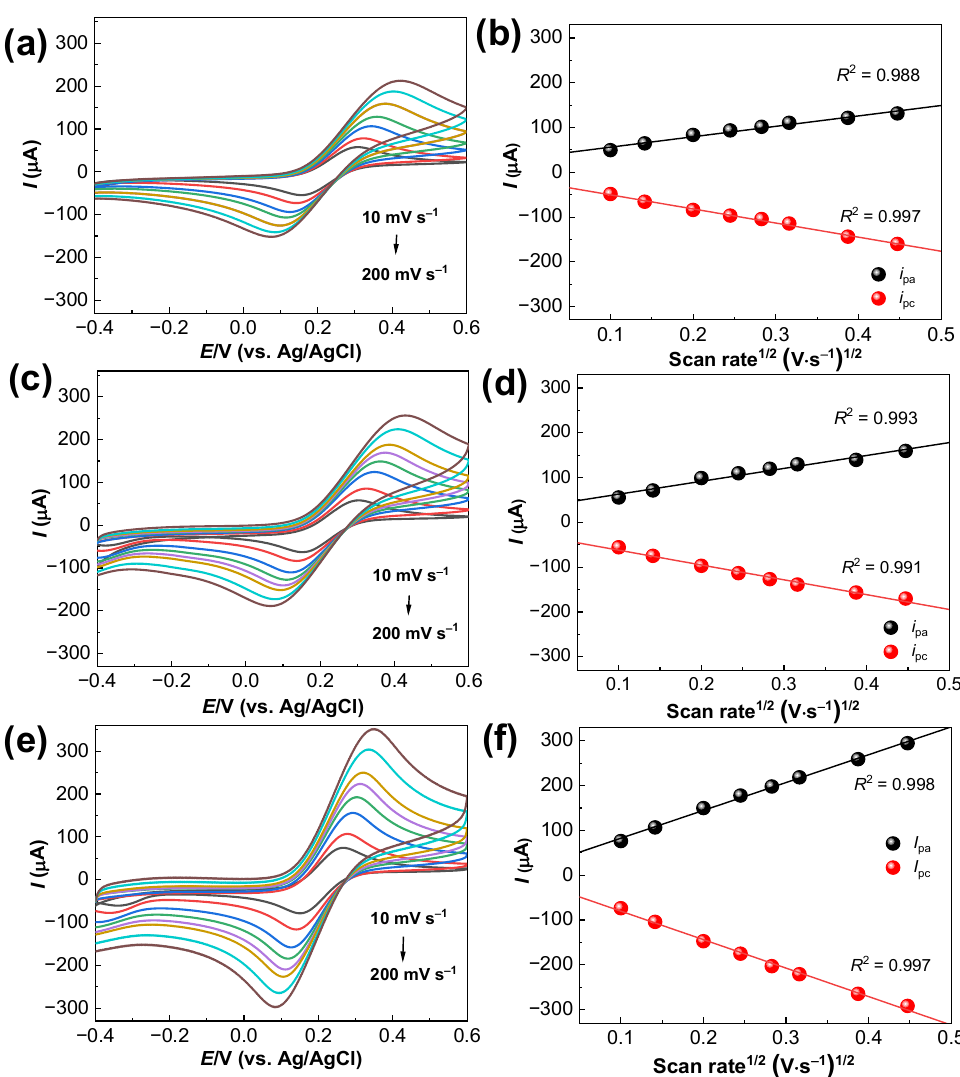
Figure 4. ( a ) CV results of the Bare SPCE in 5 mM Fe(CN) 6 ] 3−/4− contained in 0.1 M KCl at increasingscan rates from 10 to 200 mVs− 1 and ( b ) their corresponding calibration plot. CV results of ( c ) CNS/SPCE and ( e ) Cu-CNS/SPCE at different scan rates in the same redox probe. Calibration plots of ( d ) CNS/SPCE and ( f ) Cu-CNS/SPCE. In the calibration plots, Black: I pa Red: I pc . The redox mechanisms of DA and the oxidation mechanism of MT on the bare SPCE, CNS/SPCE, and Cu–CNS/SPCE were examined using CV. Figure 5 shows the CV curves of the modified sensors against 2 μM DA and 6 μM MT in a deoxygenated 0.1 M phos- phate buffer solution with a pH of 7.0. Weak redox peaks for DA and MT were recorded for the bare SPCE and CNS/SPCE sensors, whereas the Cu–CNS/SPCE exhibited a well- defined oxidation peak for DA at approximately +0.223 V and a cathodic peak at 0.1 V. A